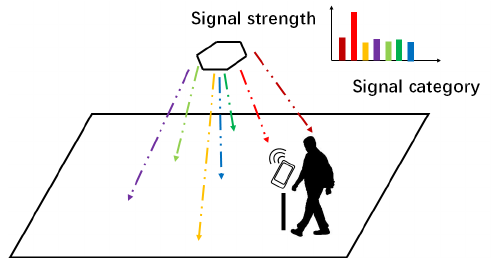
Figure 1. Indoor positioning method based on single base station audio